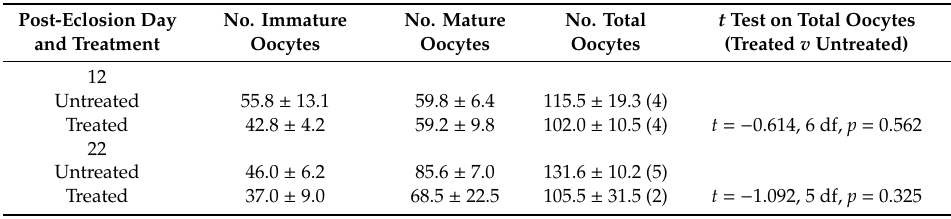
Figure 1. Mortality of caged monarch butterflies fed sugar water alone or sugar water containing 23.5 ppb imidacloprid during three weeks post-eclosion. Table 2. Oocyte production in untreated and imidacloprid-treated monarch butterflies at 12 and 22 days post-eclosion. Numbers in parentheses represent number of individuals examined.